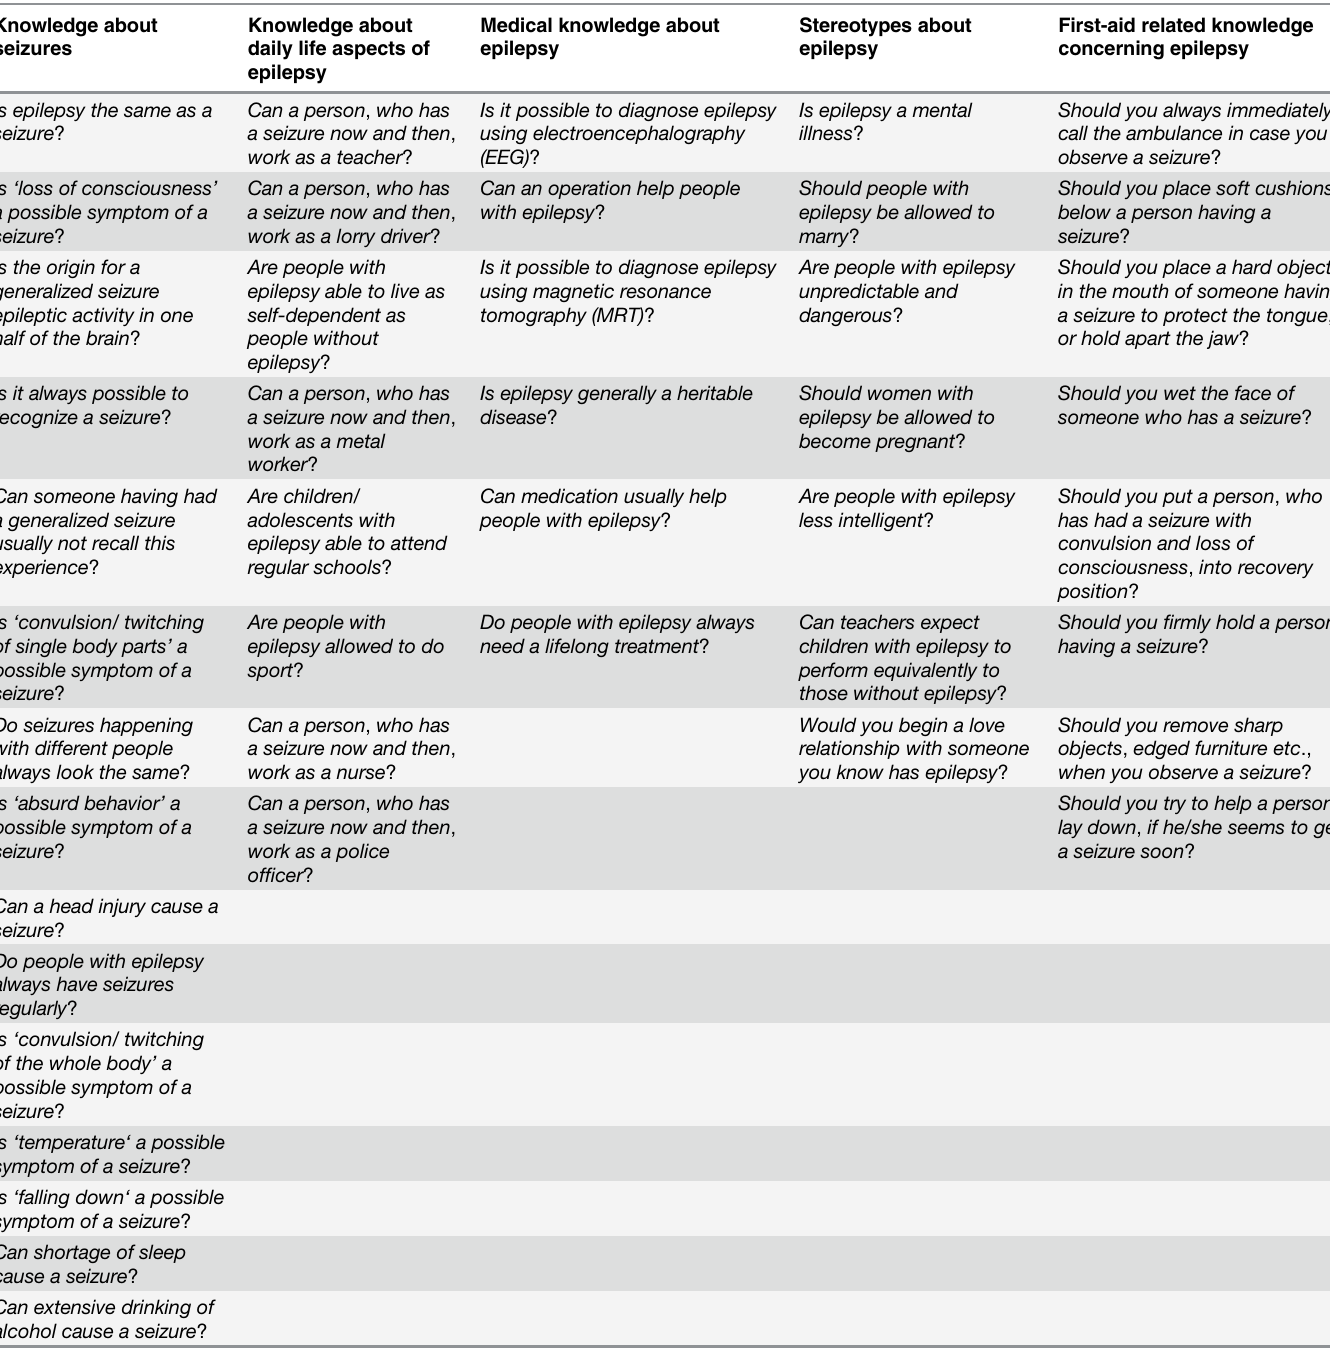
Table 1. Items from the respective knowledge/attitude domain analyzed with